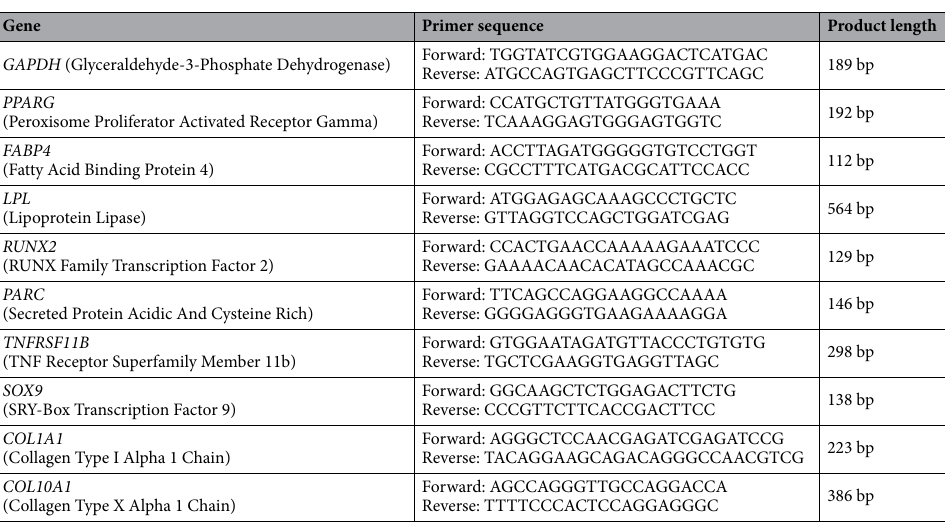
Table 2. List of primers used for RT-PCR